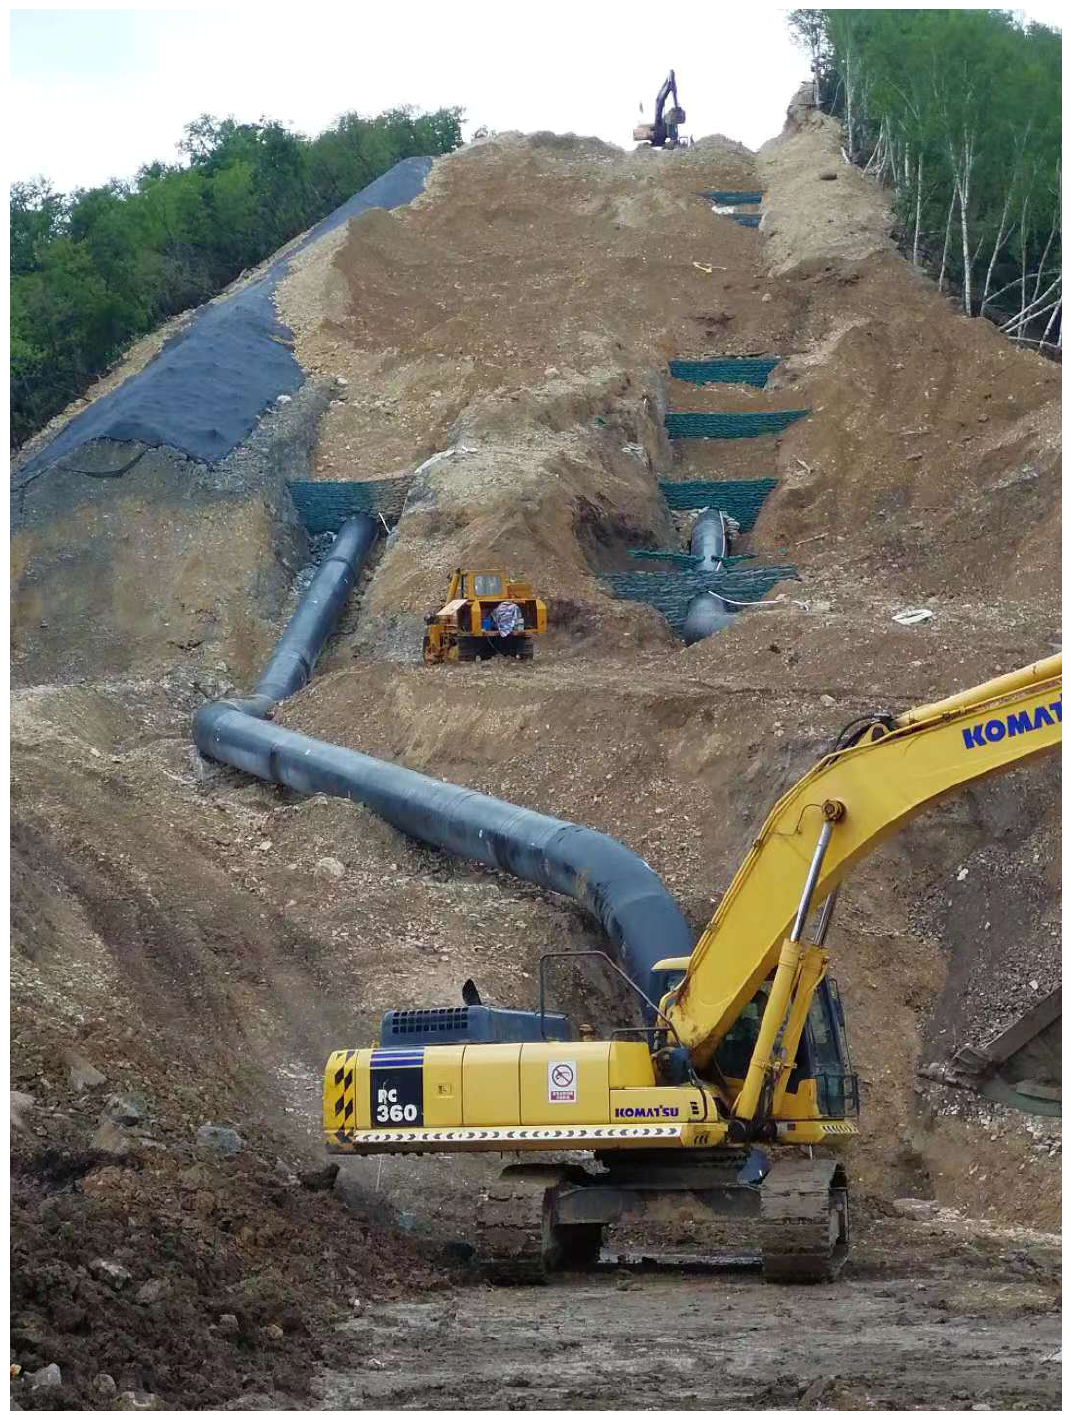
Figure 1. Deployment of oil pipelines in unstructured